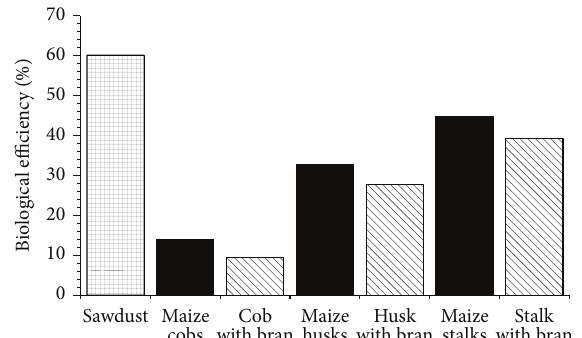
Figure 5: Biological efficiency (BE) of sawdust and maize residues. (1) Biological efficiency (BE) was a function of substrate usage to amount converted into harvested mushroom. (2) Substrates with bran contain 8.4% rice